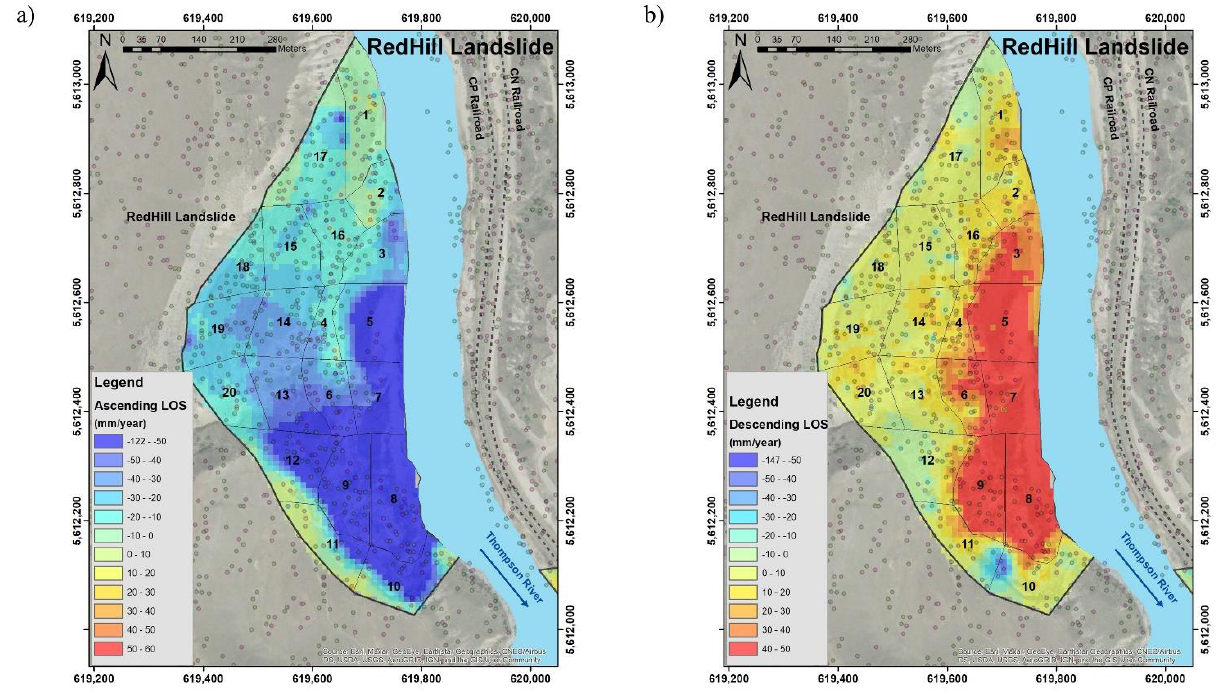
Figure 24. Cumulative 2-year LOS displacements at the Redhill landslide for ( a ) Sentinel ascending and ( b ) Sentinel descending orbits.